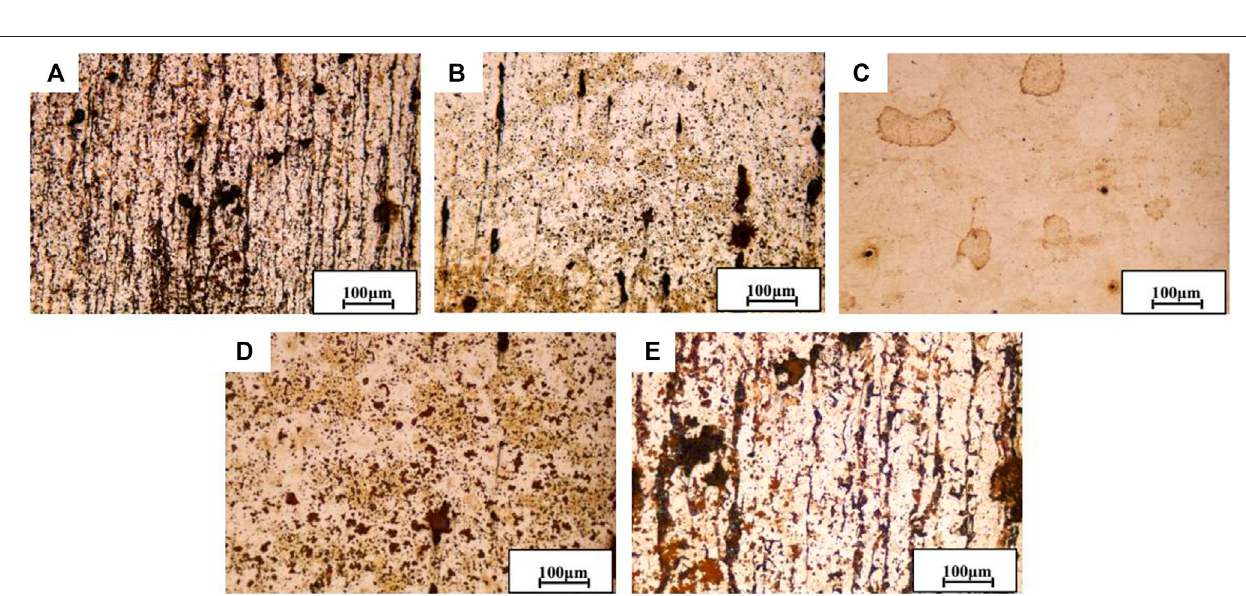
Frontiers in Materials |